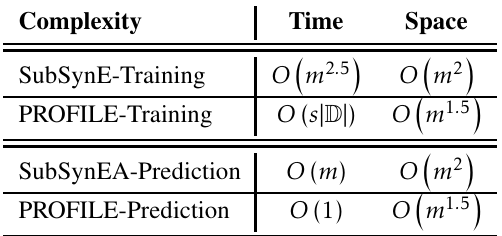
Table 2. Time and Space